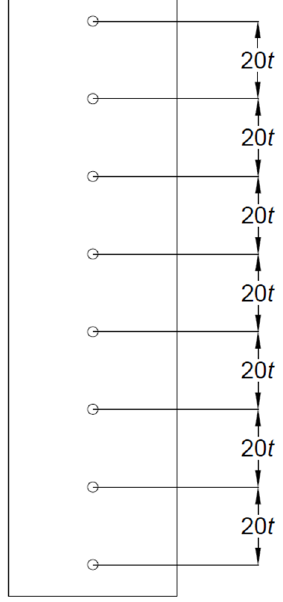
Figure 5. The flow process for fabricating the square specimens. ( 1 ). Drill the holes following the weld hole spacing. ( 2 ). Weld the plate stiffeners onto the inner surface of the outer tube. ( 3 ). Pour the concrete into the channel between the outer and inner steel and cover the top and bottom of the specimen with steel plates.